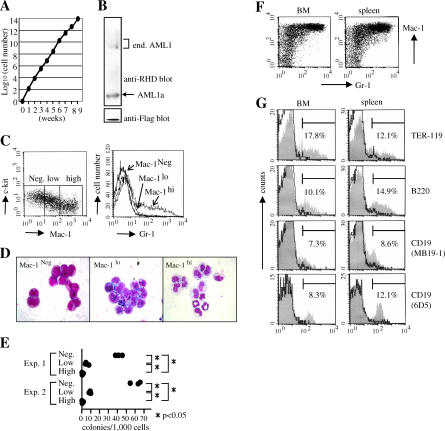
Extended Culture and Engraftment Potential of AML1a-Transduced CellsCells harvested from the third replating of AML1a-transduced cells were cultured in medium containing SCF + IL3. Cells were counted weekly and replated at 1 × 105 cells per millilitre in fresh medium and cytokines. Successful long-term cultures were established in four out of four experiments using either cells derived from BALB/c or C57BL6 mice.(A) Fold increase of cell number are presented on a logarithmic scale versus time.(B) Western blot analysis of cultured AML1a-transduced cells using anti-AML1 (anti-RHD) and anti-FLAG antibodies.(C) Flow cytometric analyses of the cultured AML1a-transduced cells using anti-c-kit and anti-Mac-1 (left) and anti-Gr-1 and anti- Mac-1 (right) antibodies.(D) May-Grunwaldt-Giemsa staining of the sorted Mac-1−, Mac-1low, and Mac-1high cells in culture.(E) CFC activity of sorted Mac-1−, Mac-1low, and Mac-1high cells in SCF and IL3. Typical data from three independent experiments conducted in triplicate are presented. Kruskal-Wallis test showed statistical significance (p < 0.05) of the three populations (Mac-1−, Mac-1low, and Mac-1high), and Mann-Whitney tests showed statistical significance of the difference (p < 0.05) of any given two populations.(F and G) Engraftment and lineage potential were analysed. Mice were lethally irradiated and transplanted with 107 cultured AML1a-transduced cells and 5 × 105 fresh “radioprotective” BM cells to mitigate against immediate effects of lethal radiation. BM and spleen cells were gated for GFP and analysed for lineage markers ten days after transplantation. Gr-1 (granulocytic) and Mac-1 (myeloid) expression in BM and spleen were analysed (F). Given the predominance of Mac-1+ cells in the graft, Mac-1− cells were analysed for TER-119 (erythroid), B220 (B-lymphoid), and CD19 (B-lymphoid) (G). Grey shading shows marker expression, and the black dotted lines show profiles of isotype-matched control antibodies. Representative data from three independent experiments are shown.